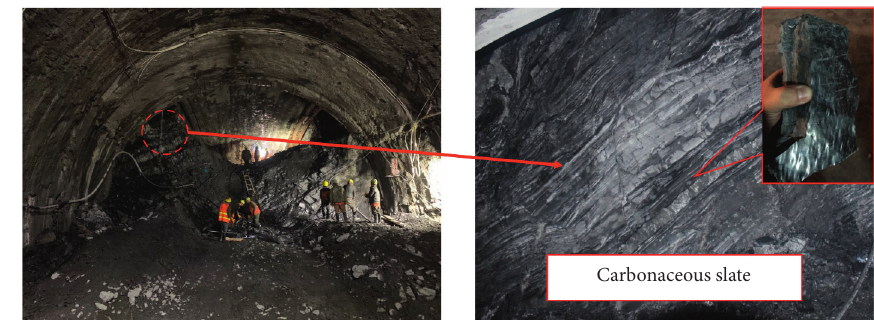
Figure 3: Surrounding rock exposure at the intersection of the tunnel.